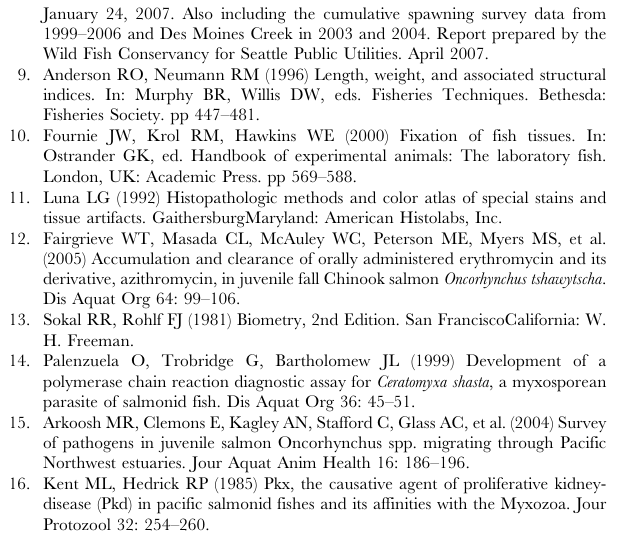
Figure S1 Number of pathogens per fish detected by pathogen screening methods for fish collected in 2003. Horizontal bar is positioned at the median. Longfellow Creek fish differ from fish from all other locations (Chi-square test, p , 0.0001). Table S1 Prevalence of infectious (parasitic/bacterial) and idiopathic conditions detected by histopathology and by pathogen screening (molecular and microscopic) in adult coho salmon sampled from several creeks and hatcheries in the Puget Sound region in 2003 and 2004. H =histopathology; PS = pathogen screening methods; 2 =analysis not performed. Video S1 Symptomatic female coho salmon in Piper’s Creek in 2000. The fish appears to be in good physical condition, with ocean-bright (silver) coloration. Characteristic symptoms include loss of equilibrium, gaping, and pectoral fin